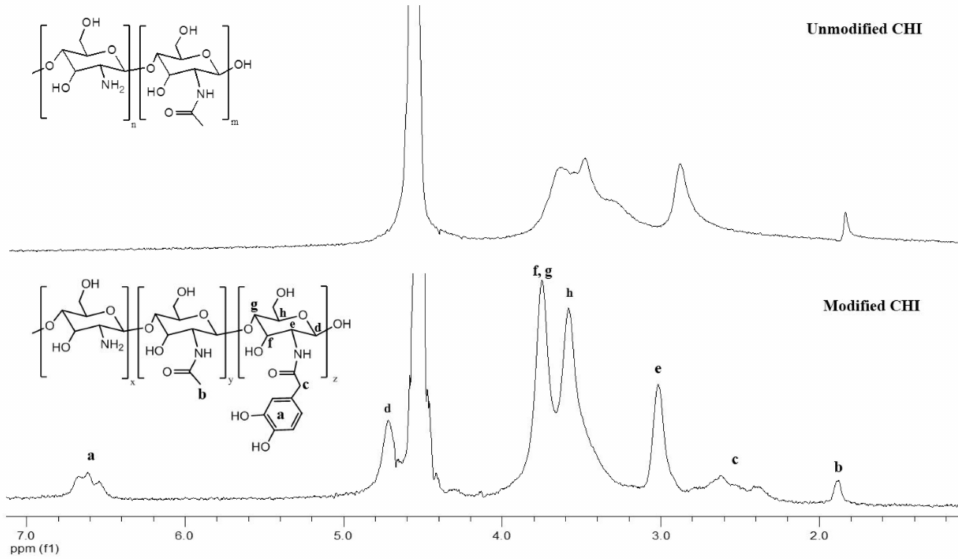
Figure 5. 1 H NMR of chitosan–catechol (modified CHI) versus unmodified chitosan (CHI) in D 2 O.